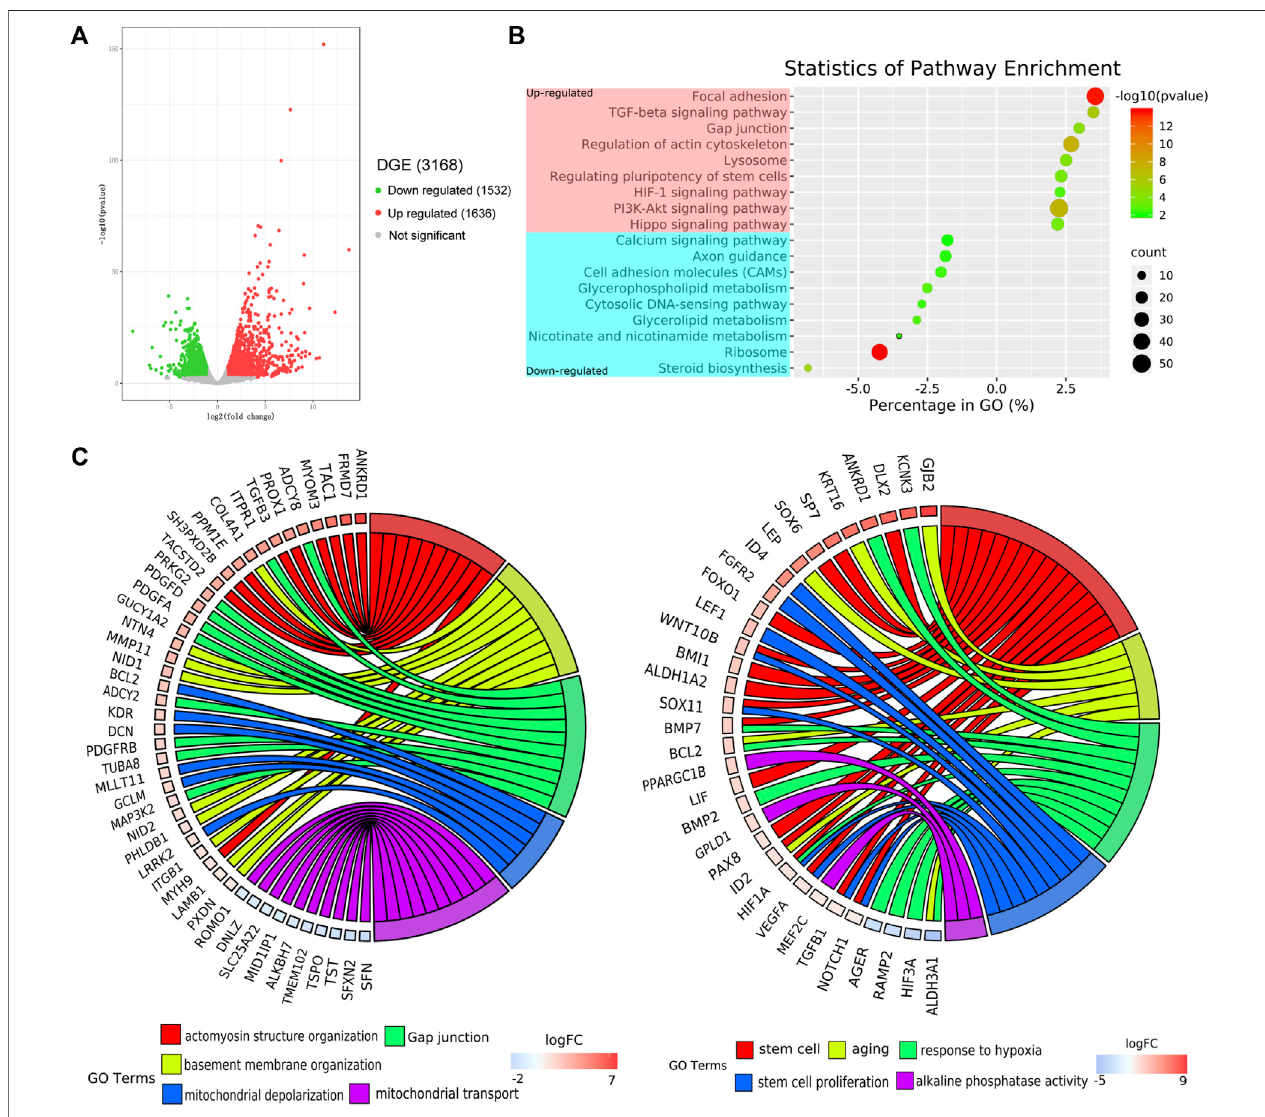
FIGURE4| Transcriptomepro fi lesofadherent3DkeratocytespheroidsonPDMS. (A) Thevolcanoplotsshowthenumberofdifferentiallyexpressedgenes(DEGs) intheadherence3Dgroupandadherence2Dgroup. (B) ThroughKyotoEncyclopediaofGenesandGenomes(KEGG)analysis,themostsigni fi cantlychangedsignaling pathways in the adherence 3D group compared with the adherence 2D group are shown. (C) The relationship between genesand signi fi cant gene ontology (GO) terms are listed by GO chords.